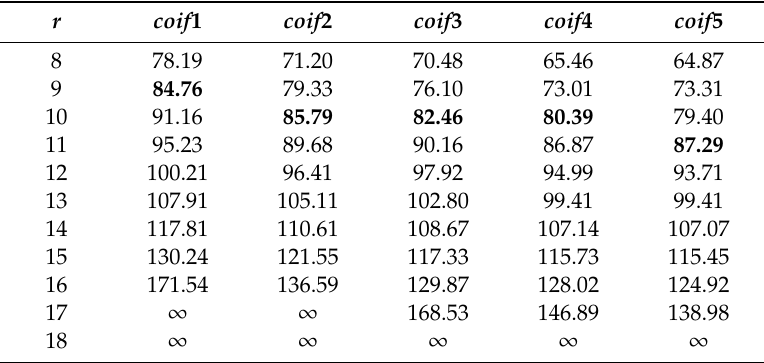
Table 29. Experimental results ( PSNR , dB) of 3D tomographic 16-bit image “Body_1.0” DWT by using bit-width r of coiflets filters coe ffi cients.